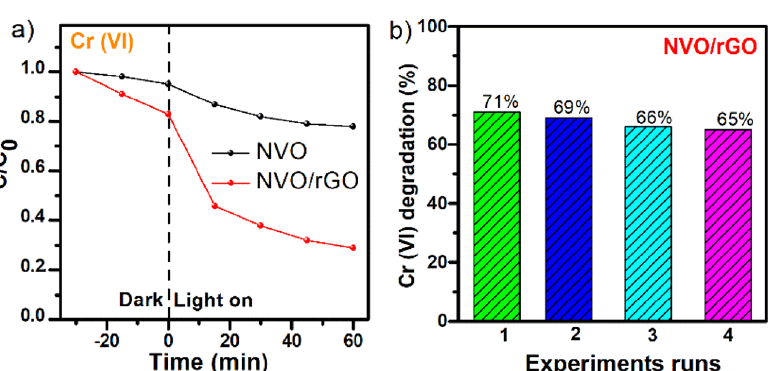
Figure 7. The photocatalytic reduction of Cr(VI) to Cr(III) under simulated solar light: ( a ) C/C0 vs t plot and ( b ) reusability of